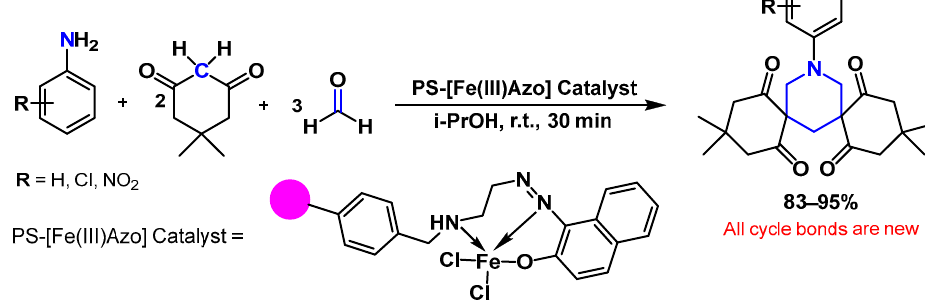
Scheme 56. Pseudo six‑component synthesis of spiropiperidine derivatives.